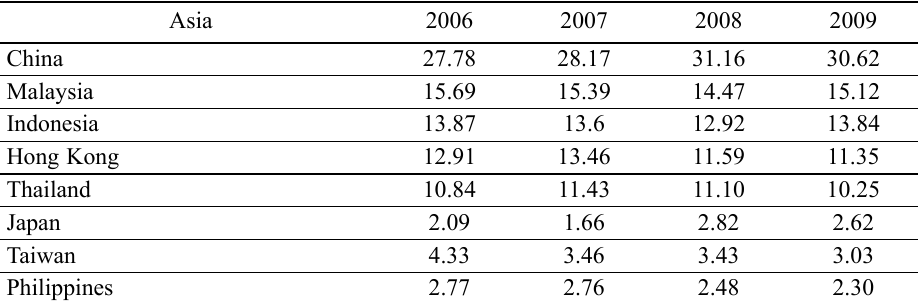
Table 5. Singapore’s OFDI within Asia (% share), 2006−2009